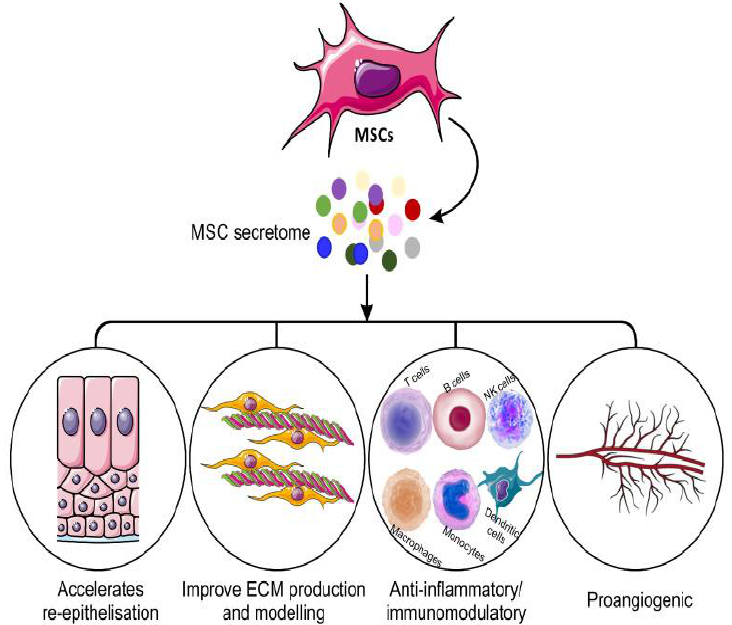
Figure 2. Mechanisms of mesenchymal stem cells secretome on wound healing. Image reproduced